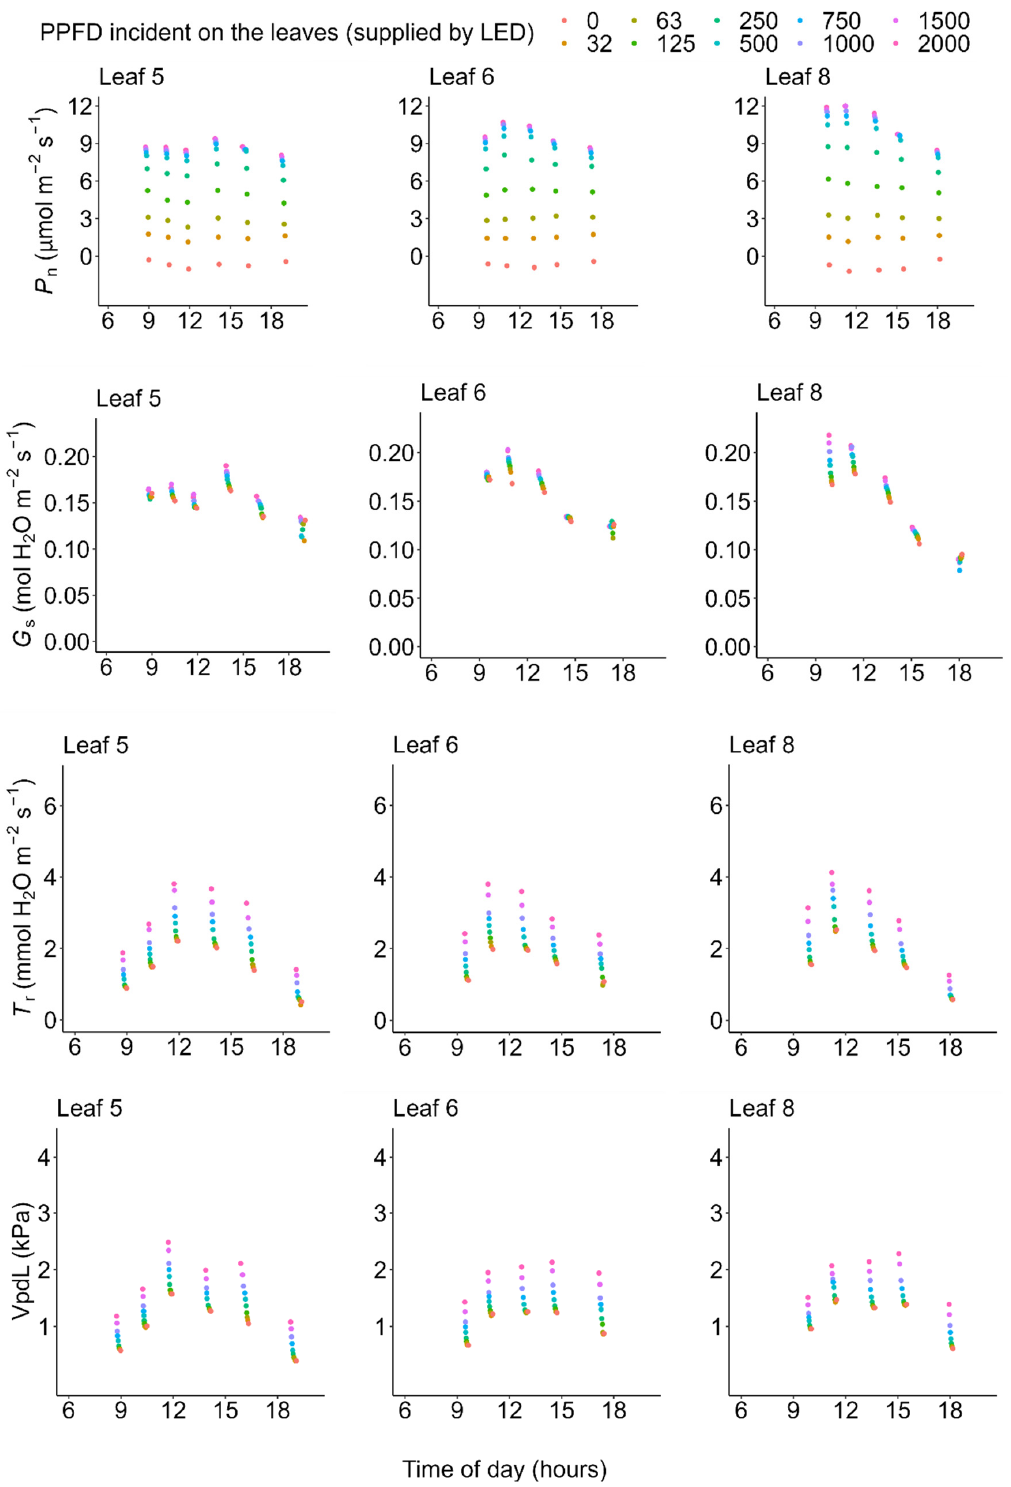
Figure 5. Diurnal courses of light-response curves on a moderately hot day (22 July 2021). PPFD: photosynthetic photon flux density supplied with an LED light source (LI-6400-02B), P n : net photo- synthetic rate, G s : stomatal conductance, T r : transpiration rate, and VpdL: vapor pressure deficit based on leaflet temperature. These values were measured with an LI-6400 system. All data are available in the Supplementary Materials.